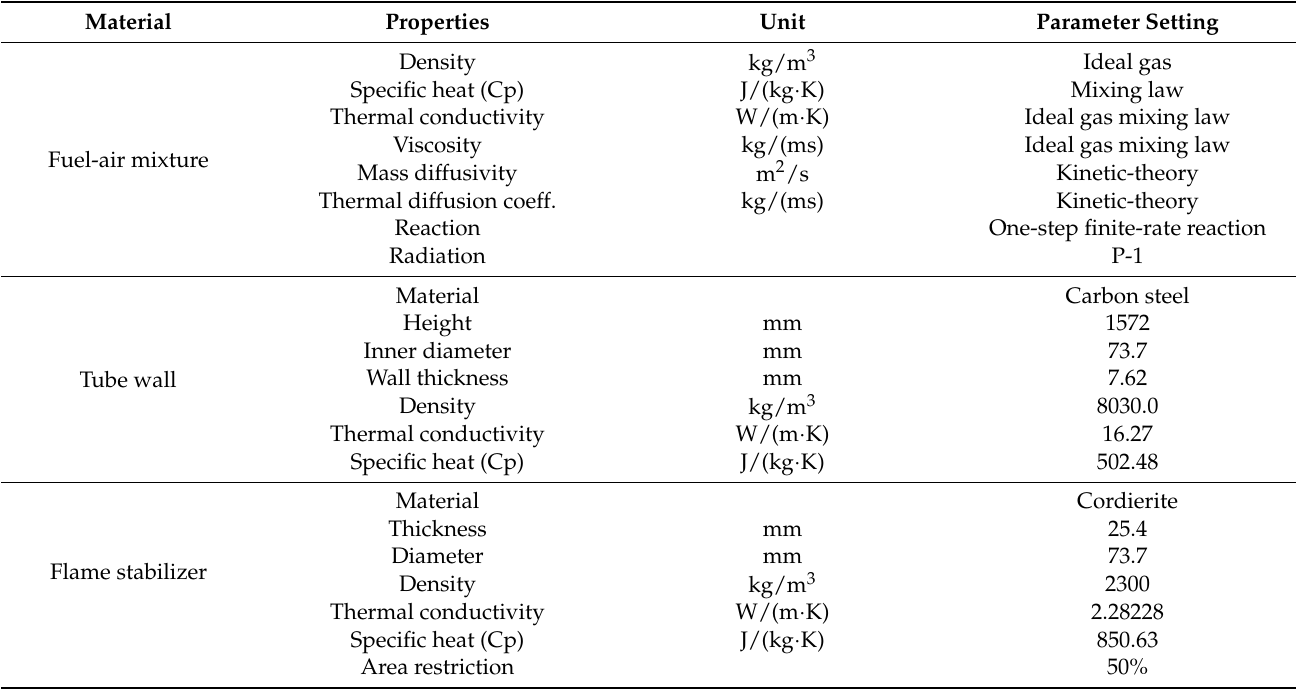
Table A3. Material properties for the Rijke burner simulation.